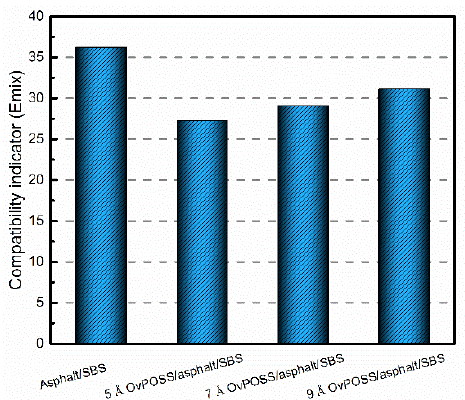
Figure 12. Compatibility indicator E mix of modified asphalt.